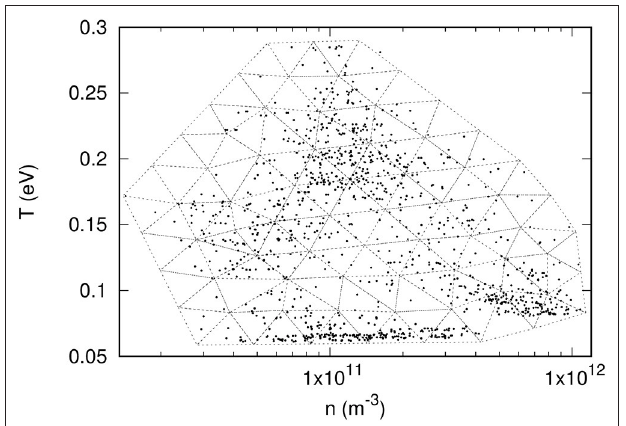
FIGURE 3 | Comparison between model-predicted and actual densities from the validation data set. The model used here was constructed with a direct optimization of five pivots. The dashed line corresponds to a perfect correlation between the two